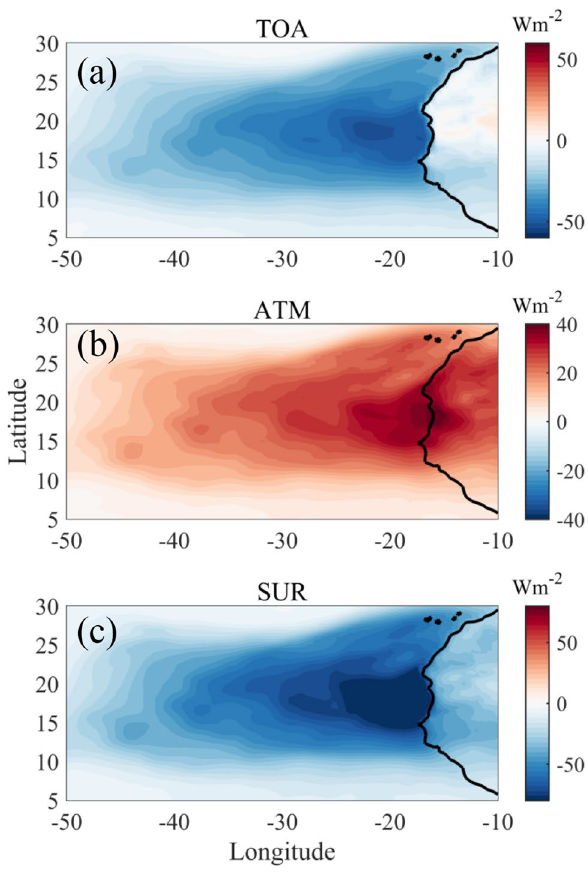
Figure 6. Spatial map (time-averaged) of ARF at ( a ) top of the atmosphere ( b ) in the atmosphere and ( c ) at the surface, using MERRA-2 datasets during the dust storm. The map was generated using MATLAB 2015b, www. mathw orks. com.